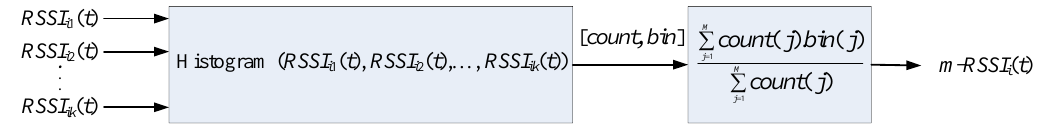
Figure 3. m - RSSI index.